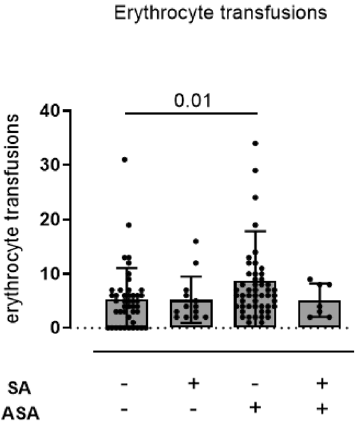
Figure 4. Amount of perioperative erythrocyte transfusion in patients with coagulase negative (n = 38/n = 53) and SA coagulase positive (n = 14/n = 9) infective endocarditis without and with antiplatelet medication. The amount of erythrocyte transfusion was more frequent in SA− patients with acetylsalicylic acid (ASA) medication. Red blood cell transfusions did not differ between patients without ASA and patients with SA+ endocarditis with ASA (Erythrocyte transfusions—SA−/ASA−: 5.364 ± 5.719 transfusions; SA+/ASA−: 5.231 ± 4.285 transfusions; SA−/ASA+: 8.686 ± 9.195 transfusions; SA+/ASA+: 5.143 ± 3.078 transfusions).